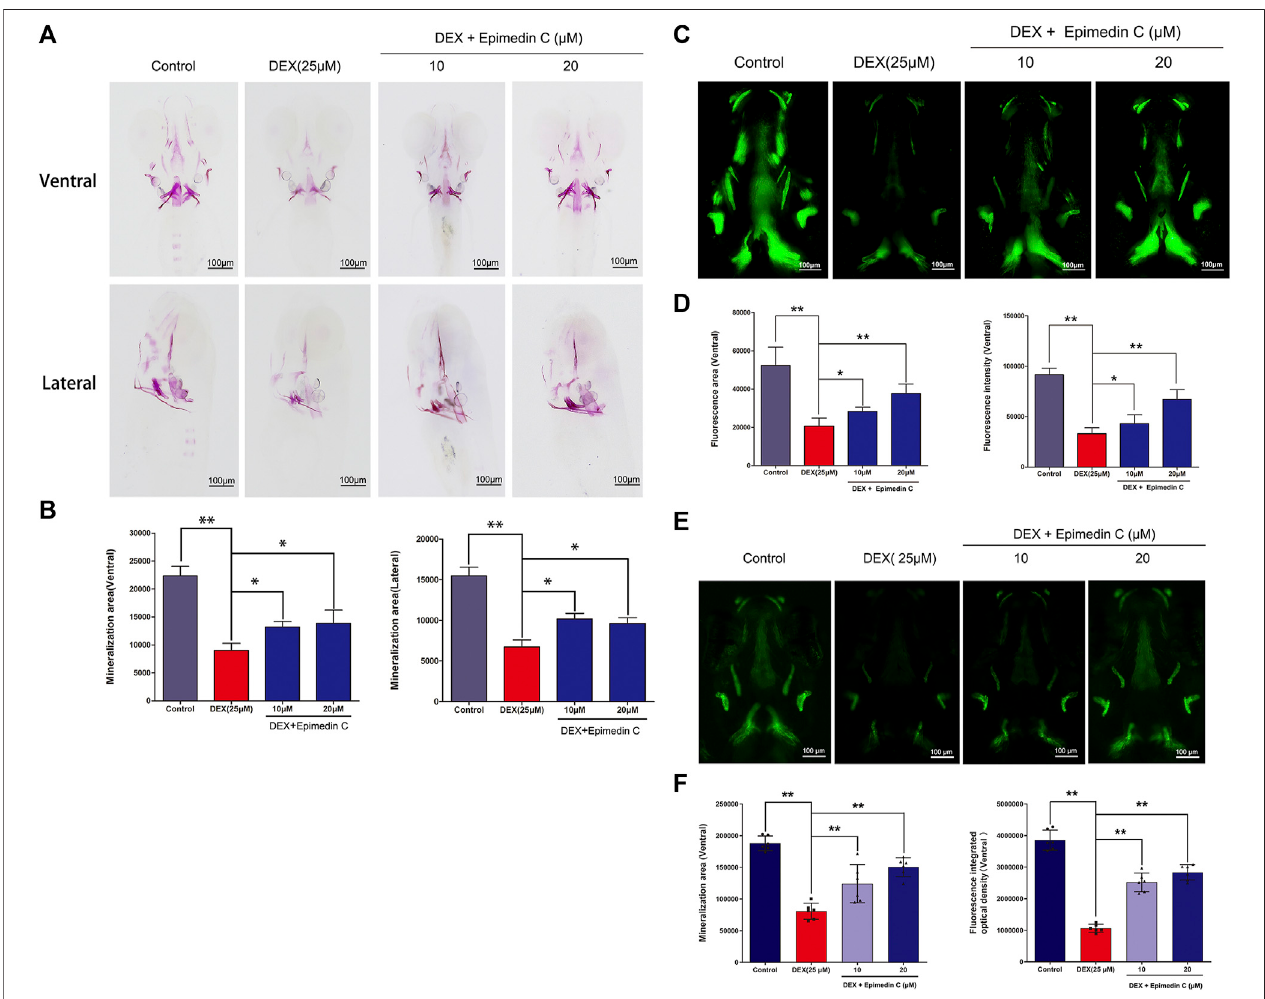
FIGURE 7 | In zebra fi sh larvae, epimedin C reduced DEX-induced mediated reductions in skull mineralization. (A) To determine the magnitude of skull mineralization, the zebra fi sh larvae within the DEX, and DEX + epimedin C (10 and 20 μ M), and control groups were stained with alizarin red S. (B) IPP was employed to examinetheregion ofskull mineralization stainedwithalizarin red S. (C) Toassess the extent ofskullmineralization, zebra fi sh larvaewithintheDEX, and DEX +epimedin C (10 and 20 μ M), and control groups were subjected to staining using calcein. (D) IPP was utilized to investigate the fl uorescence region of skull mineralization stainedwith calcein. (E,F) :Zebra fi sh TG(ola.sp7:nlsGFP) treatedwith DEX and DEX +epimedin C(10 and 20 μ M) and photographed using a fl uorescence microscope. *p < 0.05, **p < 0.01.